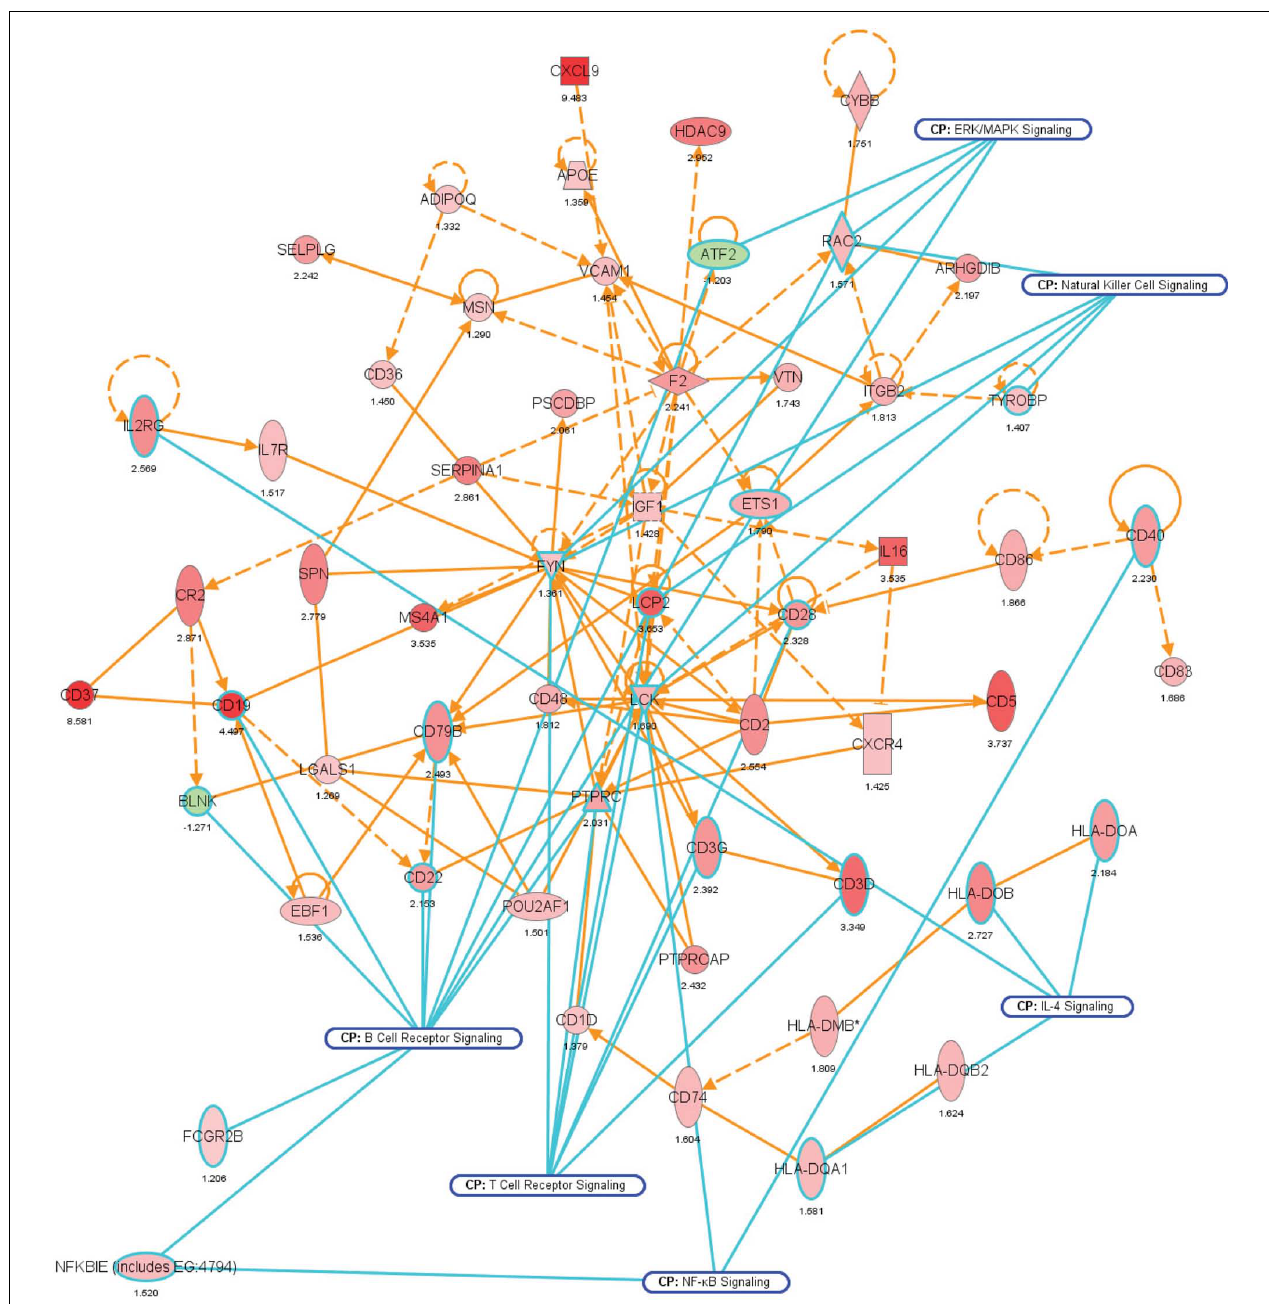
genes, with deeper shades of red indicating stronger up-regulation, and deeper shades of green indicating stronger down-regulation.The genes and their encoded proteins that are used to reconstruct specific networks were selected based on overrepresentation of GO categories (“cellular functions” in IPA) and involvement in significantly (see Materials and Methods) modulated canonical pathways.The overlays with blue radiating lines represent some of these canonical pathways (CP) and are useful to indicate in which cellular pathways differentially regulated genes and their interacting products participate for the given GO categories. Note that in this network exemplifying the genetic regulation of the mouse colonic immune response to A. muciniphila , most of the genes are up-regulated, indicating that the immune response was induced following colonization of these